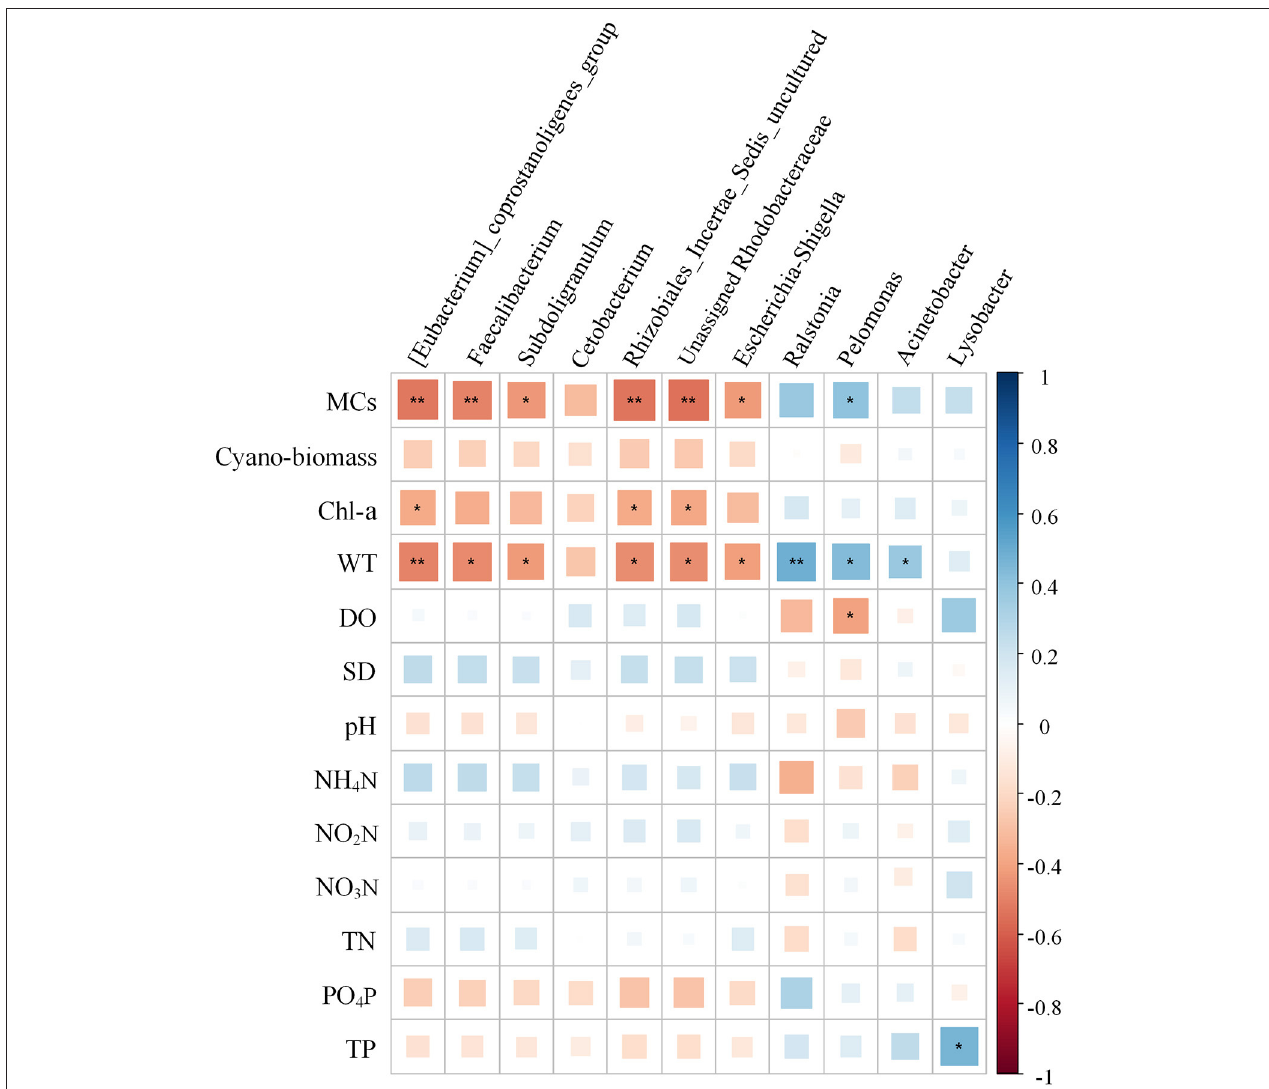
FIGURE 7 | Relationship between the abundant discriminant taxa and environmental factors. The significance is noted as follows: ** P < 0.01; * P < 0.05; and “blank,” not significant. Cyano-biomass: Cyanobacteria biomass.